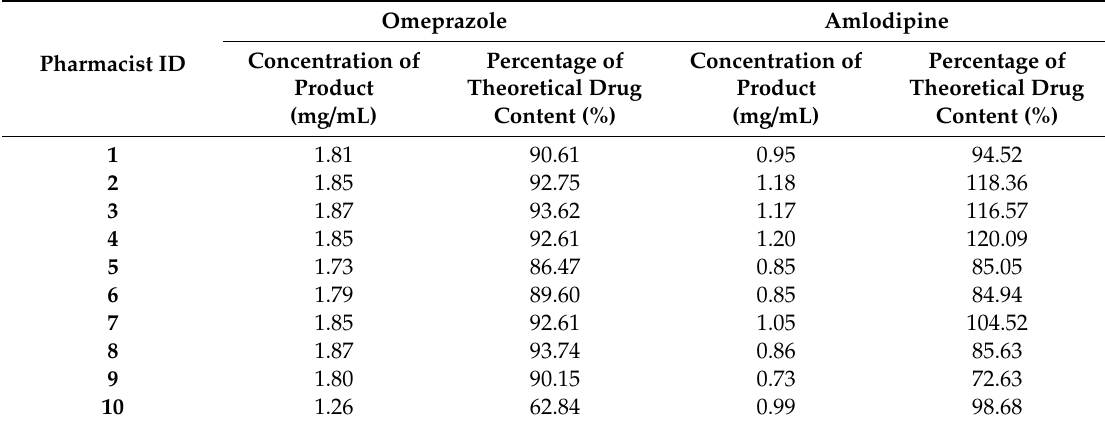
Table 2. Day 0 drug content of the omeprazole and amlodipine formulations prepared by